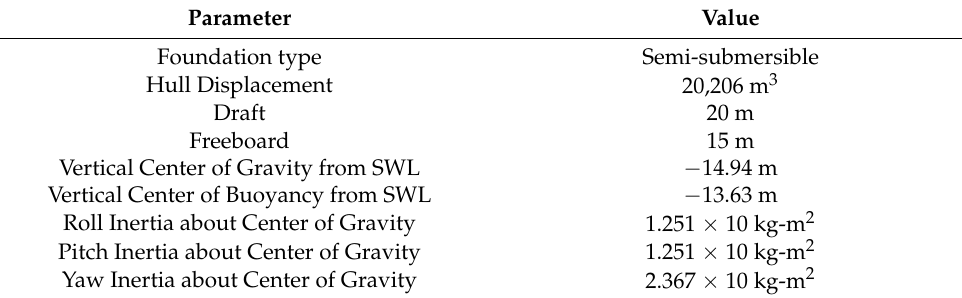
Table 3. Properties of the mooring system.